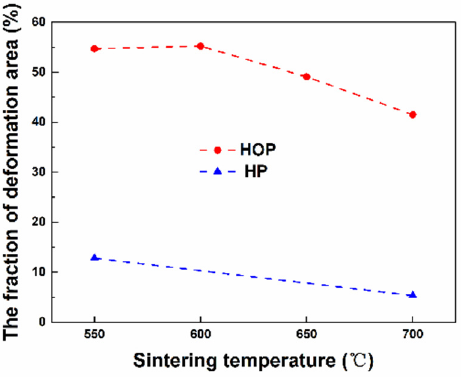
Figure 8. Fraction of deformation area as a function of sintering temperature for samples sintered by HOP and HP.